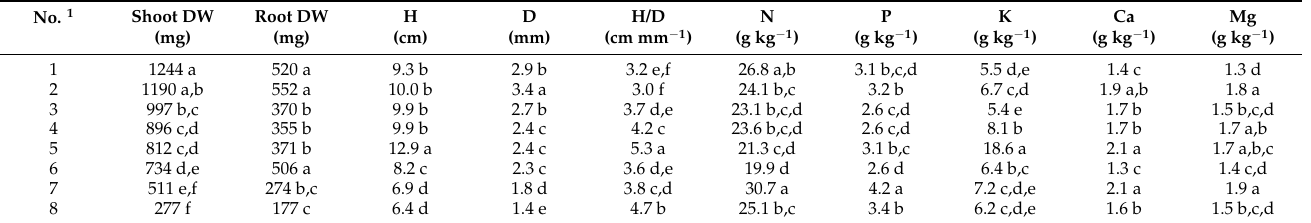
Table 3. Morphological variables of white spruce seedlings (1+0) and nutrient concentration of N, P, K, Ca and Mg in shoot tissues ( n = 3).